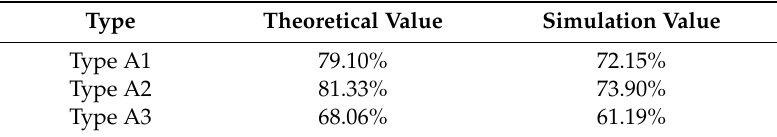
Table 6. Comparison of theoretical and simulation values of types A1, A2 and